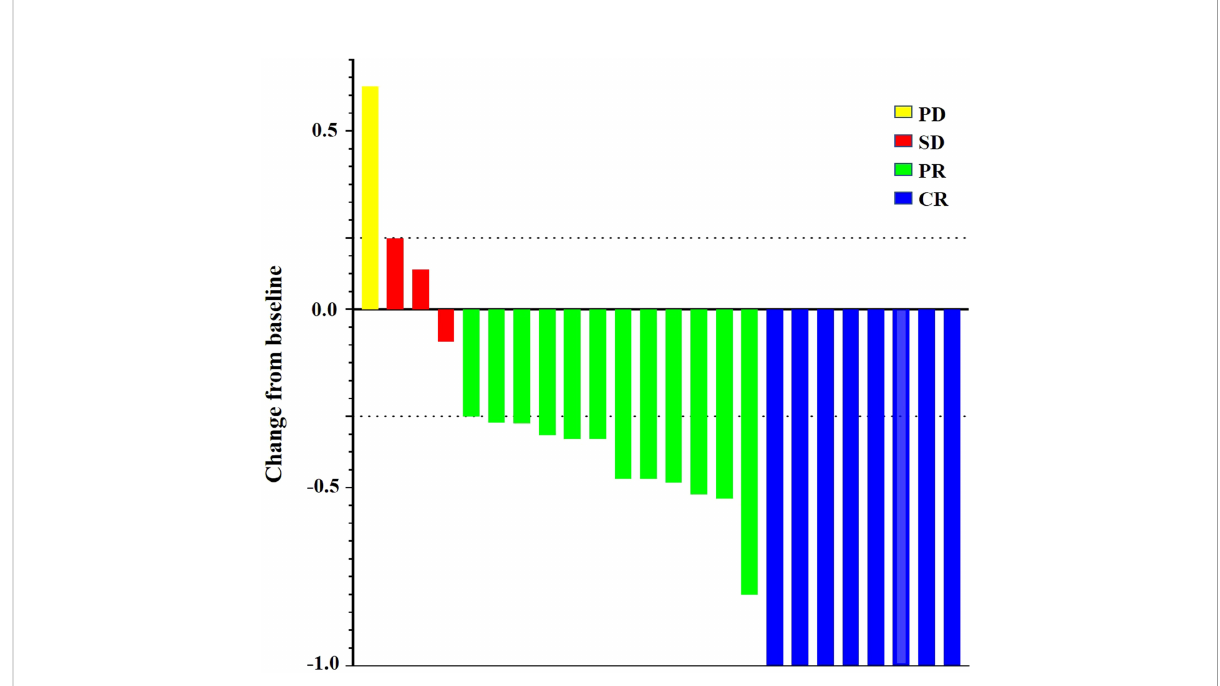
TABLE 4 Most common treatment-related AEs in the triple therapy group.